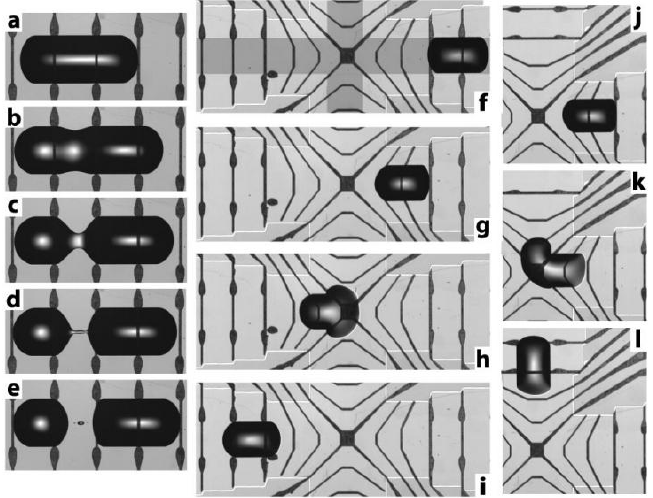
Figure 19. ( a – e ) Thermally induced splitting of a dodecane drop on a partially wetting stripe (w = 1,000 µm). The voltage applied to the microheater (155 Ω) was 2.5 V. The images were recorded at t = 0, 6.0, 7.5, 8.0, and 8.5 s. ( f – i ) Dodecane drop propelled through an intersection outlined by the dark gray pattern (w = 1,000 µm, time lapse 104 s). ( j – l ) Dodecane drop turning a 90° corner (time lapse 164 s). Reprinted with permission from [24]. Copyright 2003, American Institute of